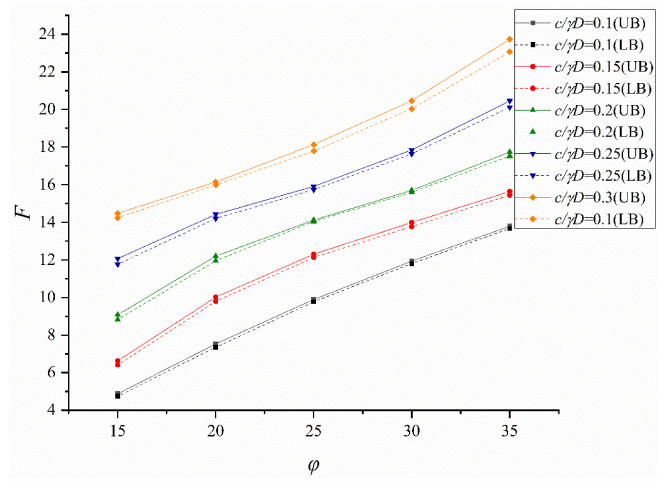
Figure 33. Influence of ϕ on the safety factors F of the global stability of adjacent construction under different c/ γ D ( C/D = 1, L/D = 1).